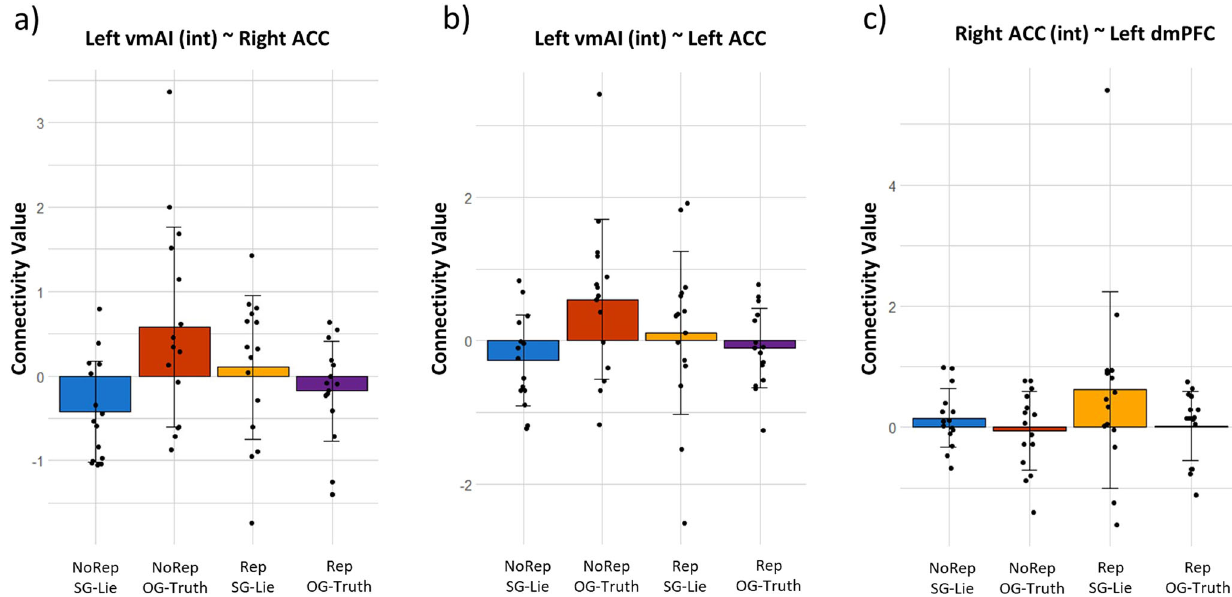
Fig. 5 Connectivity analysis results. a Stronger connectivity between the left vmAI and right ACC for self-gain lies with reputation vs. no reputation risks (yellow vs. blue bar) and for other-gain truths with no reputation vs. reputation risk (red vs. purple bar). b Stronger connectivity between the left vmAI and left ACC for self-gain lies with reputation vs. no reputation risks (yellow vs. blue bar) and for other-gain truths with no reputation vs. reputation risk (red vs. purple bar). c Stronger connectivity between the right ACC and left dmPFC for self-gain lies with reputation risk vs. other conditions (yellow vs. blue, red, and purple bars). vmAI ventromedial anterior insula, ACC anterior cingulate cortex, dmPFC dorsomedial prefrontal cortex, NoRep_SG-Lie self-gain lies without reputation risk, NoRep_OG-Truth other-gain truths without reputation risk, Rep_SG-Lie self-gain lies with reputation risk, Rep_OG-Truth other-gain truths with reputation